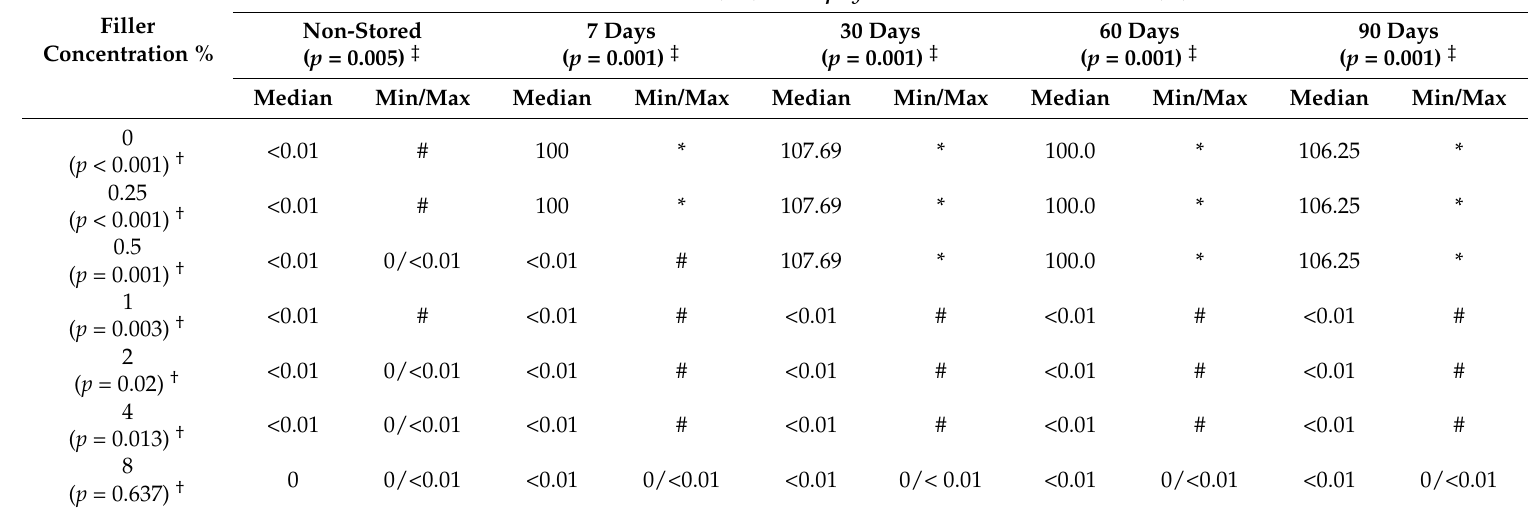
p -values marked † : refer to the SR differences listed in rows (different storage durations for a particular material); and those marked ‡ : refer to SR differences listed in columns. *: no changes in quadruplicate; #: both below 0.01 but more than